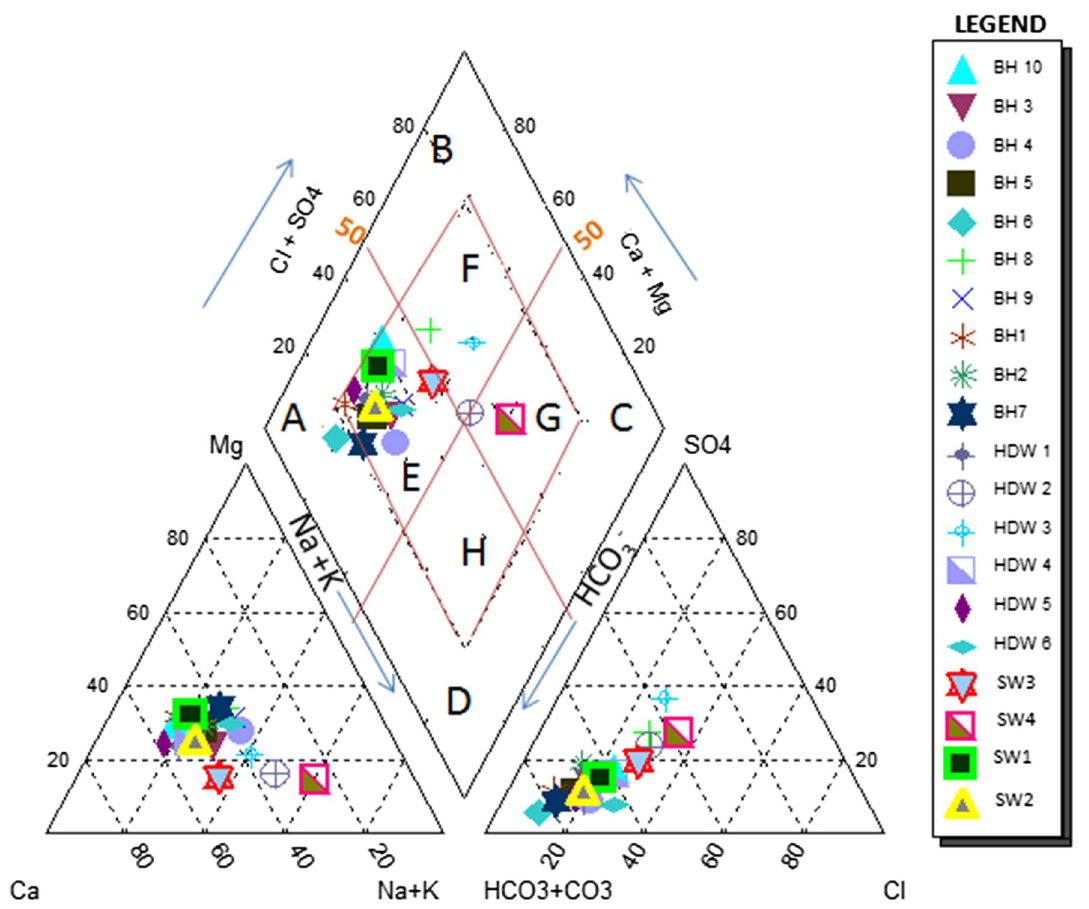
Fig. 10 Piper trilinear graph showing hydrochemical facies and the evolutionary